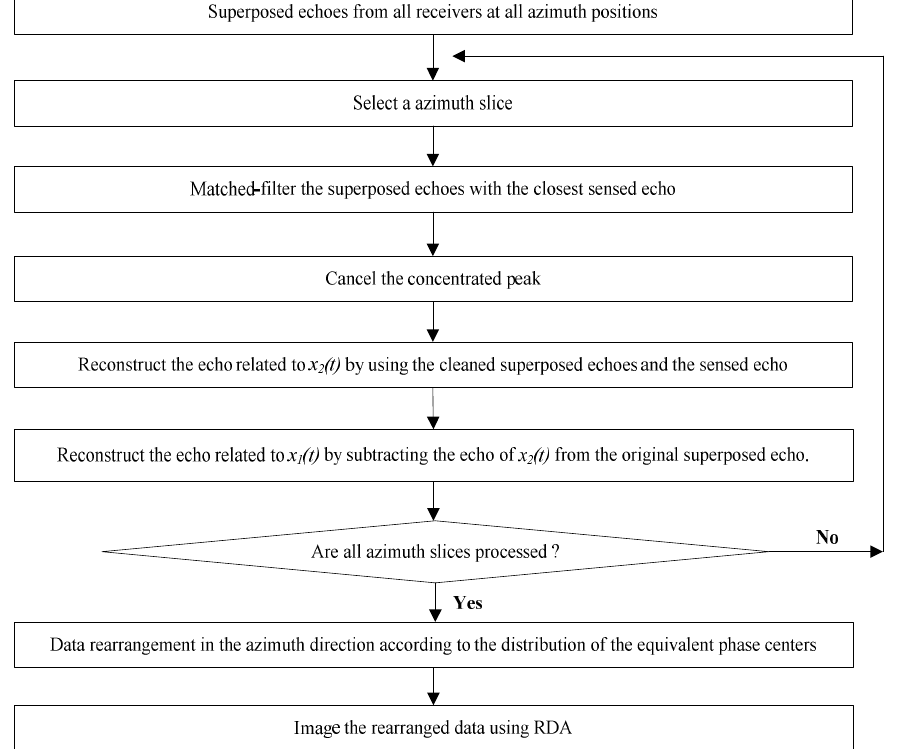
Figure 5. Procedure of the proposed scheme used for MIMO-SAR orthogonal waveform separation.